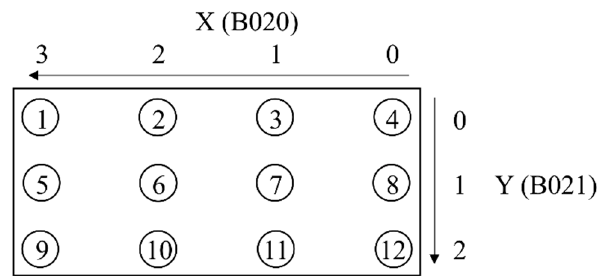
Figure 12. Rack with position labels used in SAMI (inside the circles) and used in the robot jobs (next to the arrows).